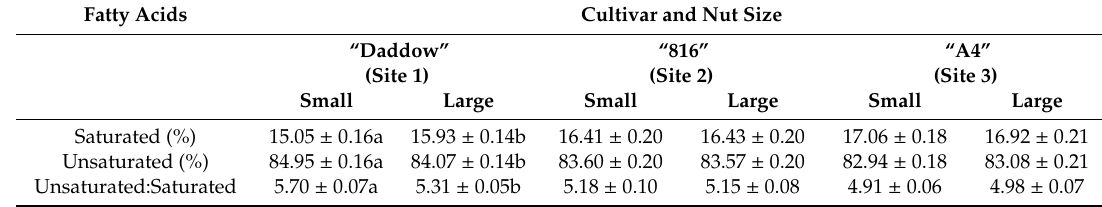
Table 3. Relationships between nut size, relative abundances of fatty acids (%), and fatty acid ratios in kernels from macadamia cultivars, “Daddow”, “816” and “A4”, each sampled at one of two commercial orchard